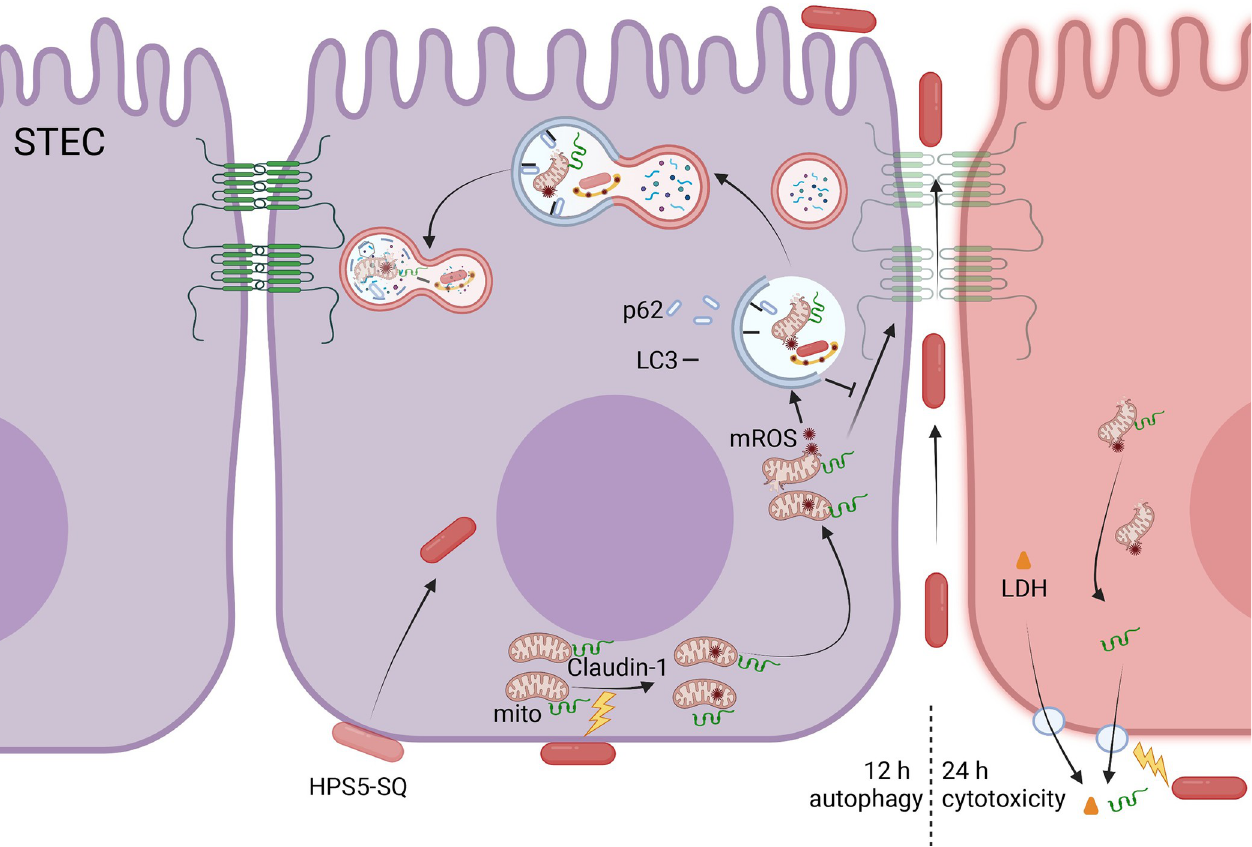
Fig 7. Diagram of the destruction of the respiratory epithelial barrier in the infection of HPS5-SQ. Autophagy induced by mROS facilitates the damage of the respiratory epithelial barrier in the infection of HPS5-SQ. In brief, autolysosomes can degrade mitochondrion and Claudin-1. In addition, cytotoxicity induced by HPS5-SQ infection accelerates the escape of Claudin-1 from the cytoplasm. Consequently, the Claudin-1 degradation and escape in the STEC make cell membrane Claudin-1 unable to replenish in time, and the respiratory tract epithelial barrier is